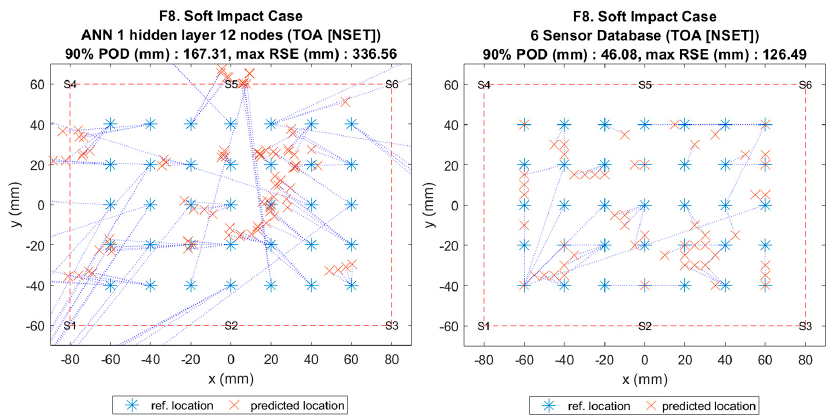
Figure 11. Visualisation of impact localisation for soft impacts (F8) using different methods: ANN (left) and reference database (right).